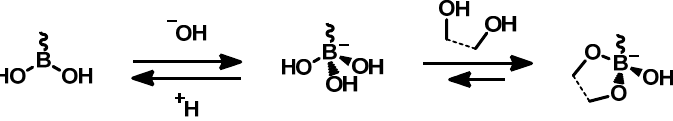
Figure 1. Simplified boronic acid equilibrium in the presence of a diol.